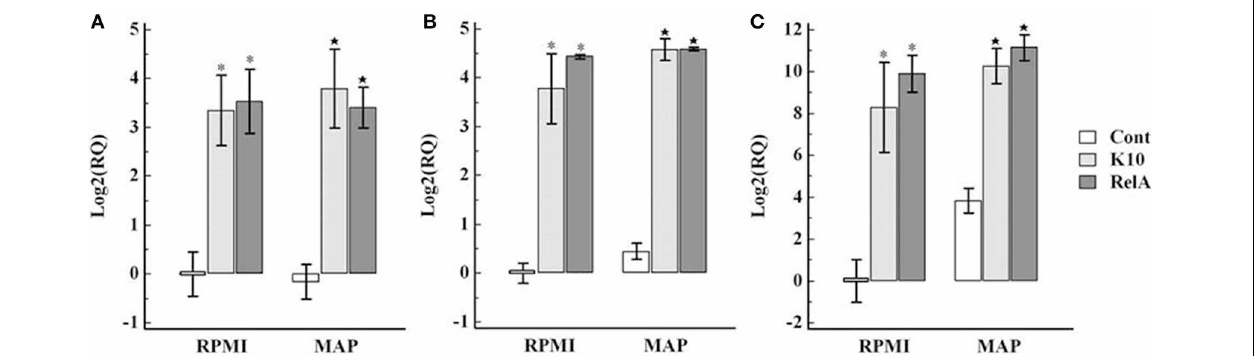
FIGURE 7 | Relative transcription of genes involved in Th1 type immune response in PBMC. PBMC were isolated from animals in each group and cultured with and without live Map for 3 days. The level of mRNA transcription of PBMC was measured by qRT-PCR. The relative quantification of each cytokine was calculated using the value of PBMC isolated from